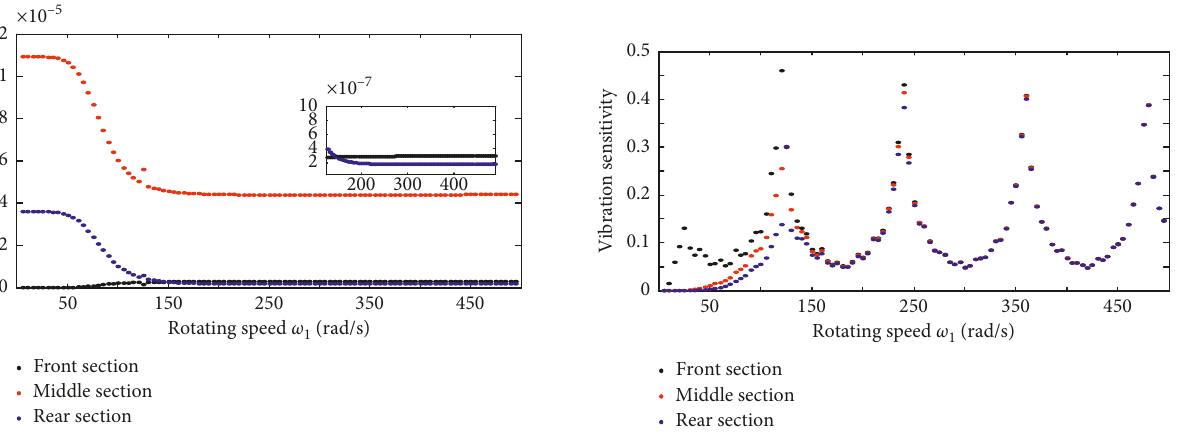
Figure 10: Energy transmissibility η with varying rotating speed of low-pressure rotor ω l : front section (black), middle section (red), and rear section (blue).